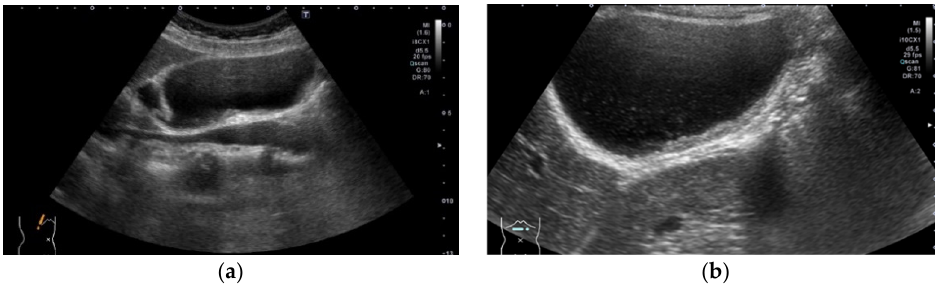
Figure 2. Evaluation of GB using a HRUS technique. Compared with an image of routine US ( a ), localized slight thickening of an inner hypoechoic layer was clearly shown in the magnified image using a high-frequency transducer ( b ) (GBC case).